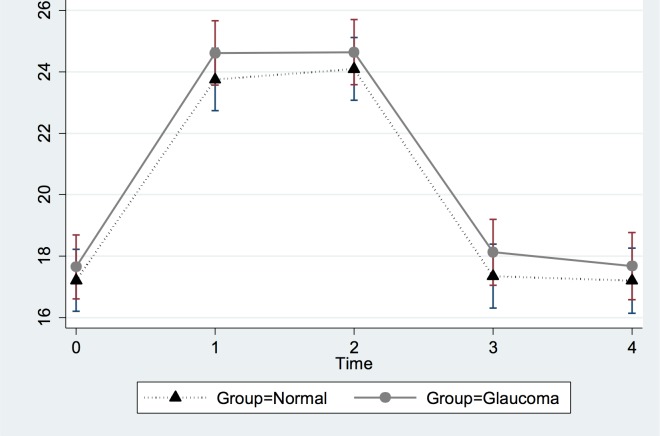
Predictive Margins of Diagnostic Groups versus Time with 95% Confidence Intervals.